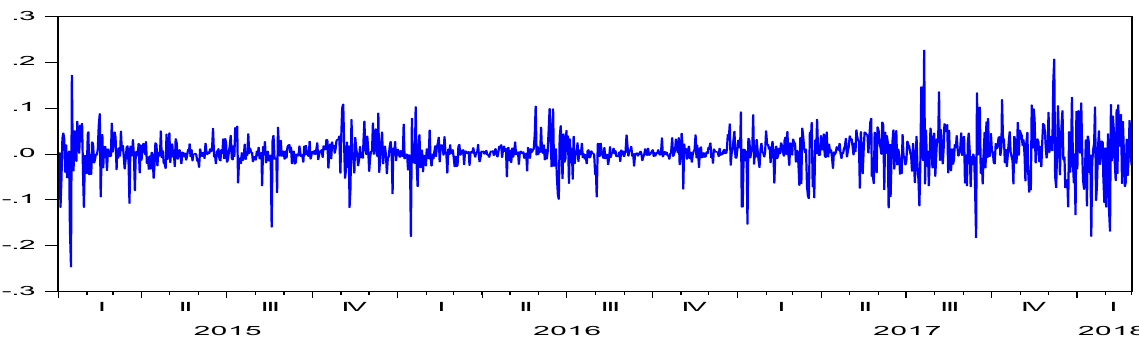
Figure 2. Return, Logarithmic Returns of Bitcoin. The top panel of the graph illustrates the daily returns of Bitcoin over the period time and the bottom panel of the graph illustrates the daily logarithmic returns of Bitcoin.